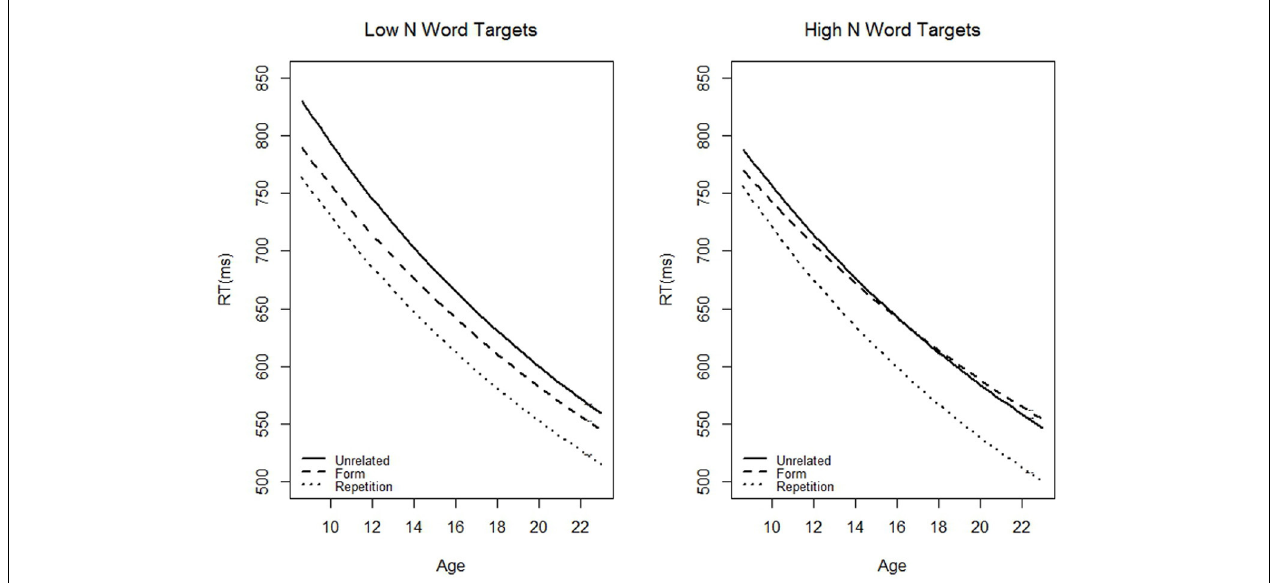
FIGURE 1 | The predicted (based on our models) average reaction time to targets preceded by the three different prime types as a function of age (in years). This model used the high N targets in adults.